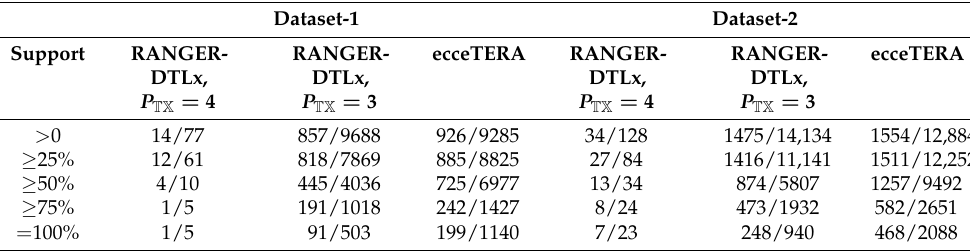
Figure 5. Impact of increasing support values on TX event accuracy. The support for an event is defined as the percentage of optimal solution space that the event appears in. Table 4. Number of TX events inferred by the different methods, along with their precision, are shown for different minimum support value cutoffs. Results are aggregated across all 500 gene tree/species tree pairs in each dataset and presented in the form a / b , where b is the total number of distinct TX events inferred across 100 randomly sampled optimal reconciliations for RANGER-DTLx and across the entire optimal solution space for ecceTERA for each gene tree, and a is the number of these TX events that are